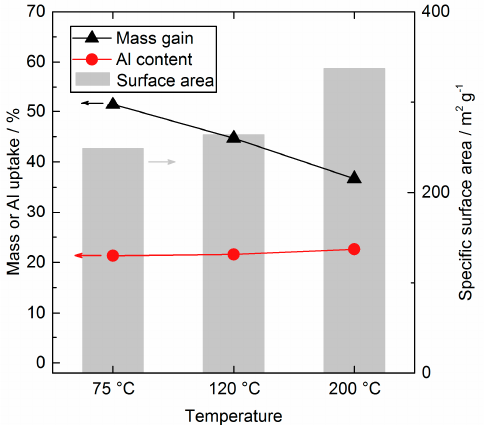
Figure 7. Specific surface area (grey, background, right axis), mass gain in wt % (black, left axis) and Al wt % (red, left axis) for different substrate temperatures after three